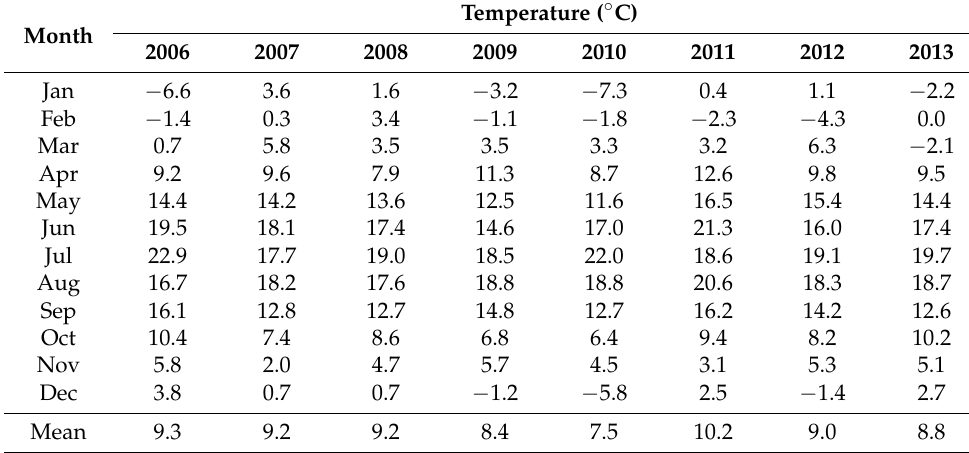
Table 3. Temperatures in